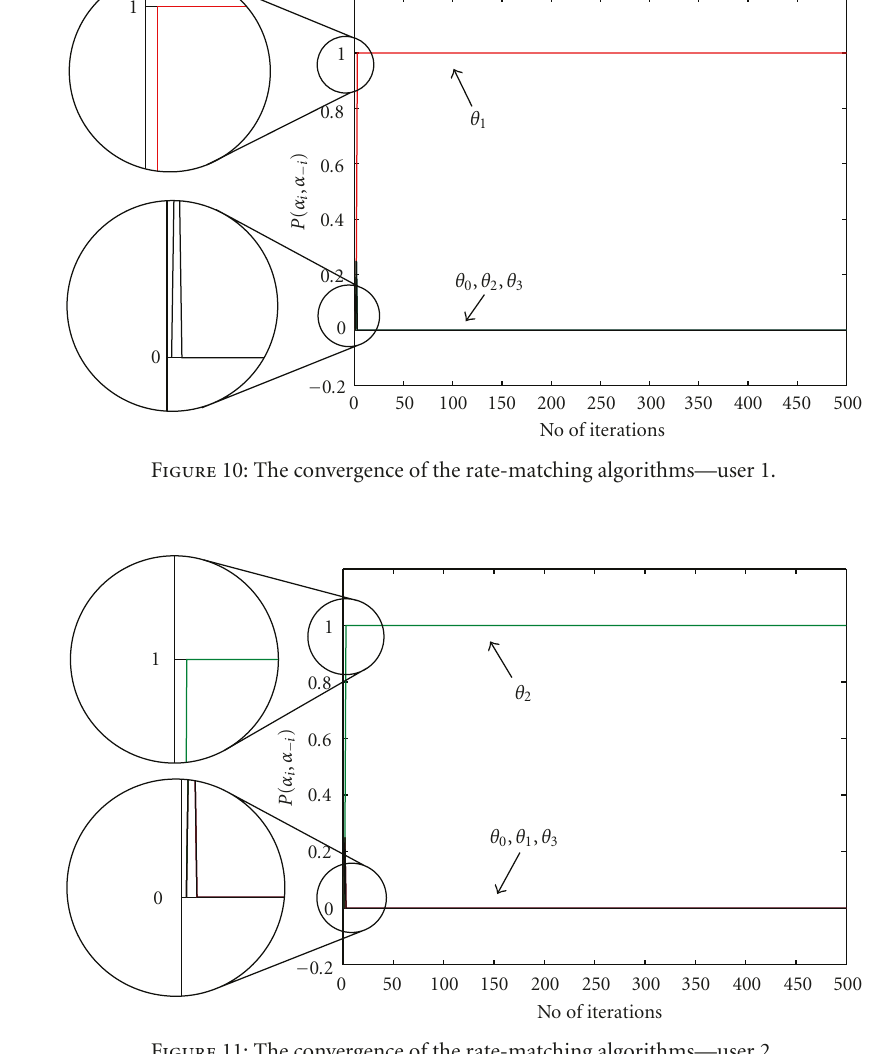
Figure 11: The convergence of the rate-matching algorithms—user 2.